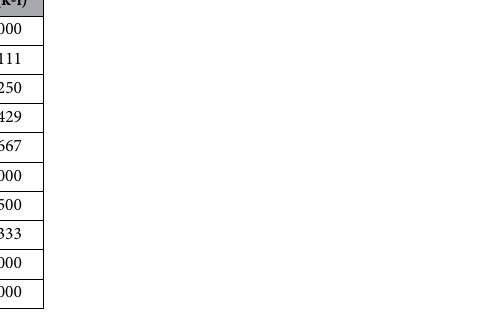
Table 5. Holm’s step-down procedure